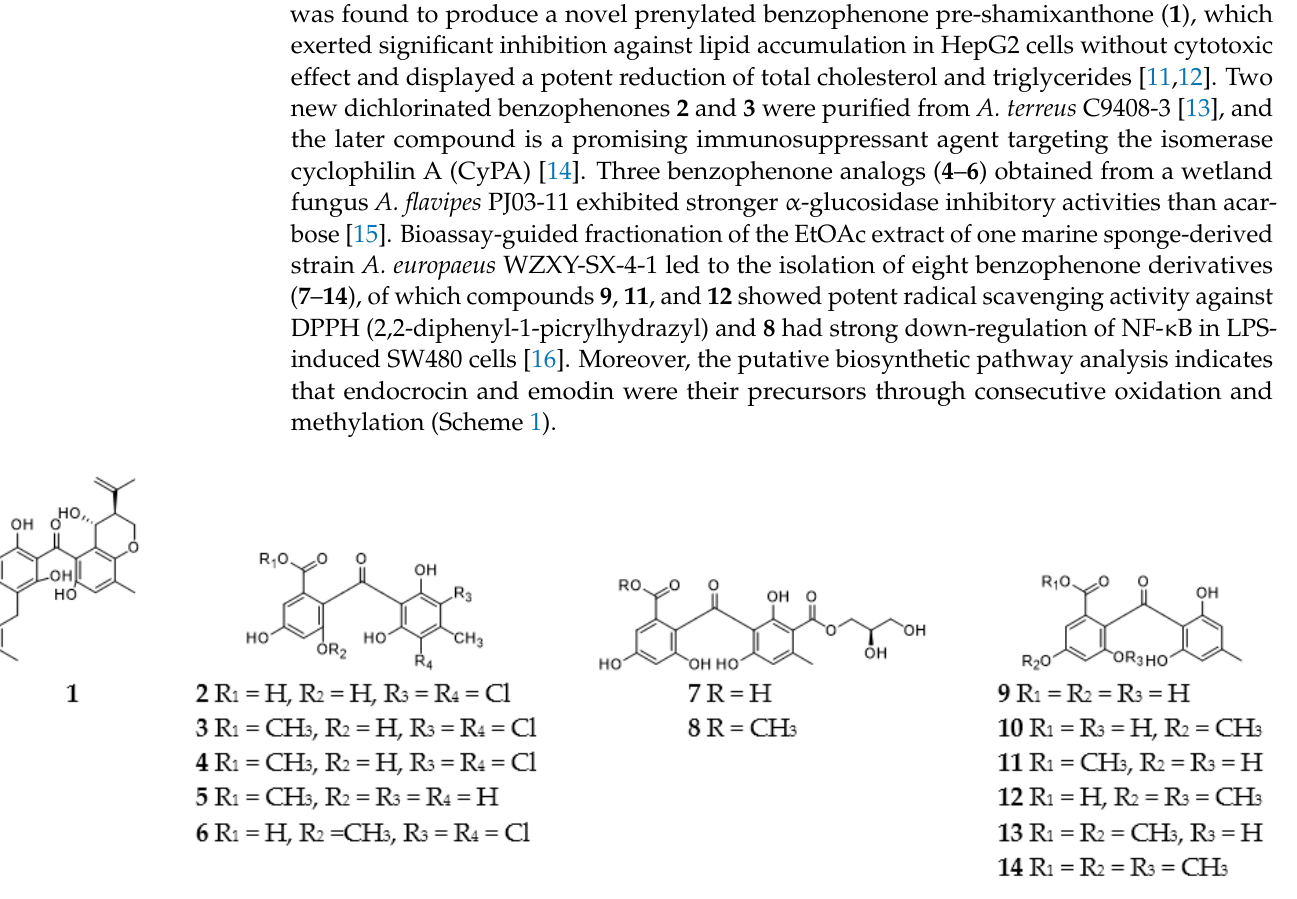
Figure 1. Aspergillus -derived benzophenones ( 1 – 14 ).